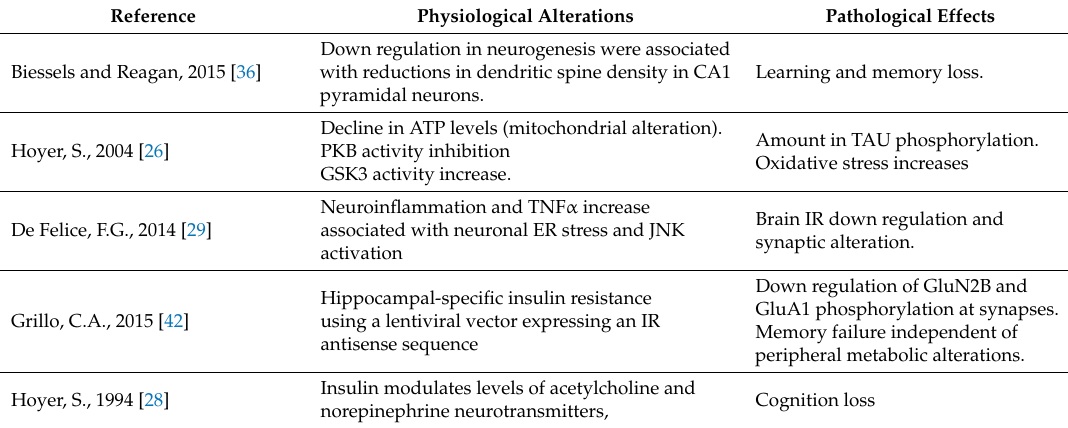
Table 1. Examples of IR signalling pathway alterations in the brain in late onset Alzheimer’s